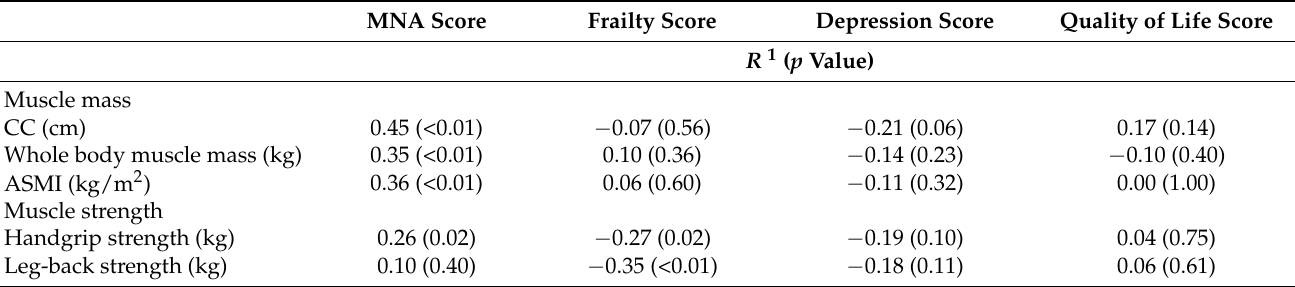
Table 3. Correlations between nutritional status, frailty, depression, quality of life and muscle function in patients with dementia.